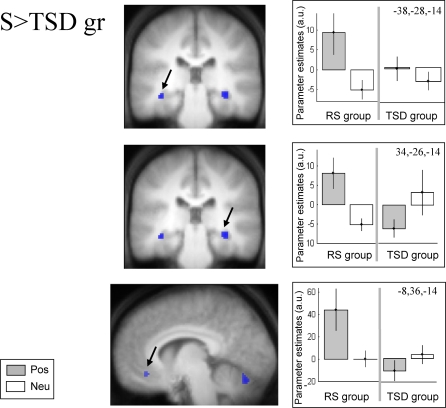
Effect of Sleep on Emotional (Positive) Memory Modulated by Performance(A) Memory (R > K) × emotion (Pos > Neu) × sleep status (RS > TSD) interaction. From the top to the bottom: both hippocampi and the medial prefrontal cortex.Pos: positive; Neu: neutral. Left panels: functional results are displayed on the mean structural MR image, normalized to the same stereotactic space (display at p < 0.001, uncorrected). Right panels: parameter estimates of recollection minus familiarity (arbitrary units ± SEM).